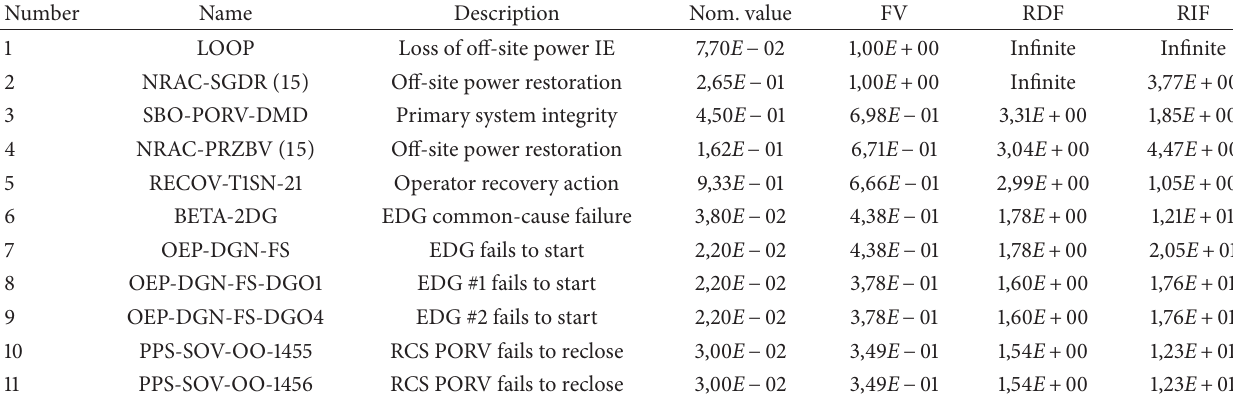
Table 12: The basic events with largest FV importance measure in SBO event tree, model with 15-minute